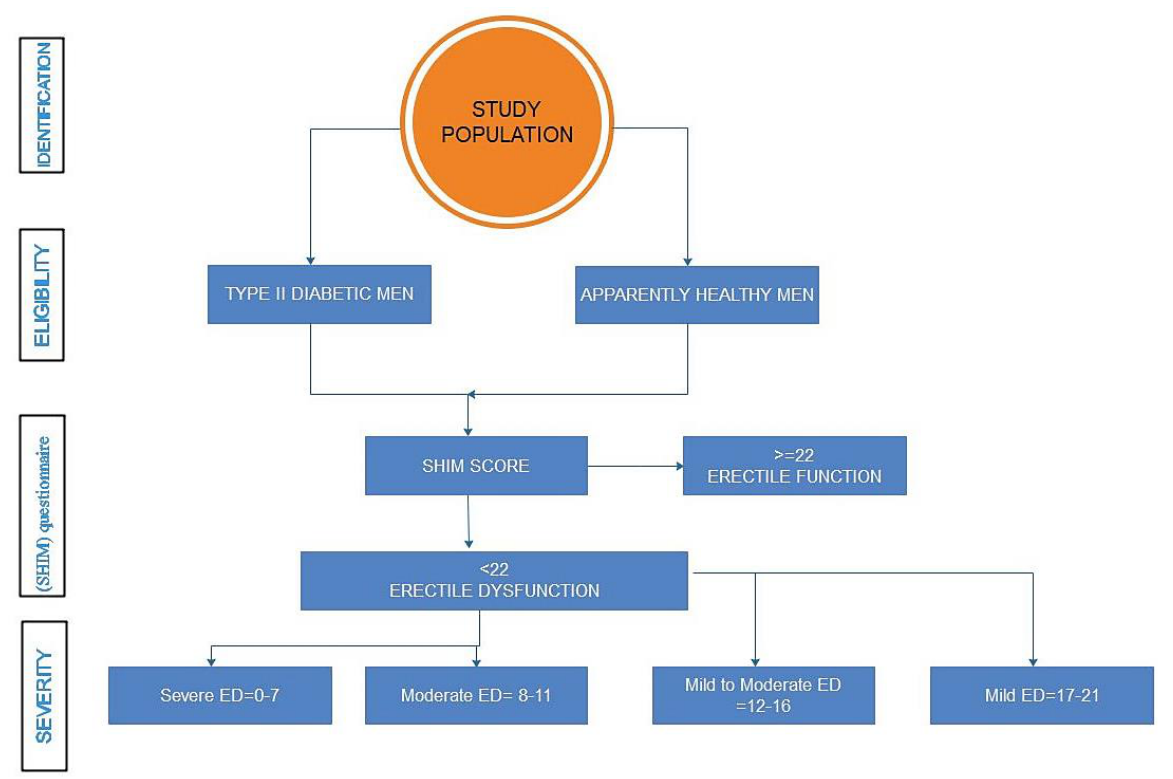
Figure 1. Flow chart of the Research